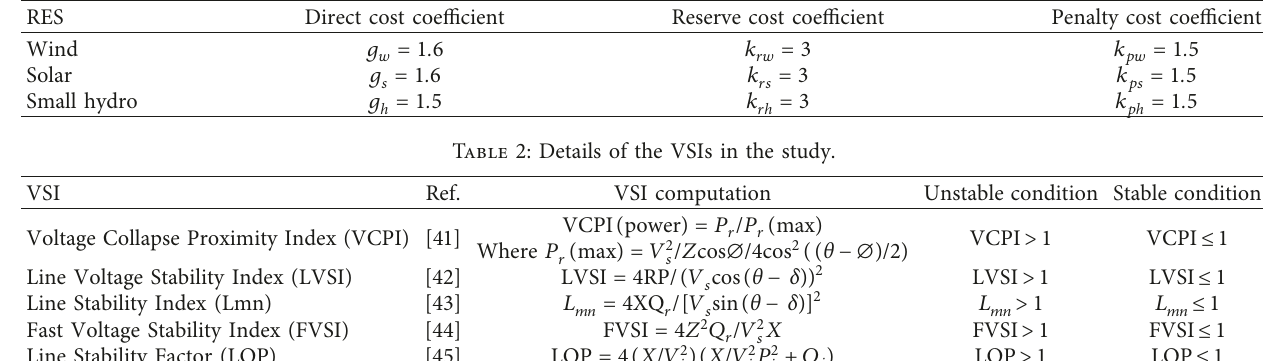
Table 1: Cost coefficients for